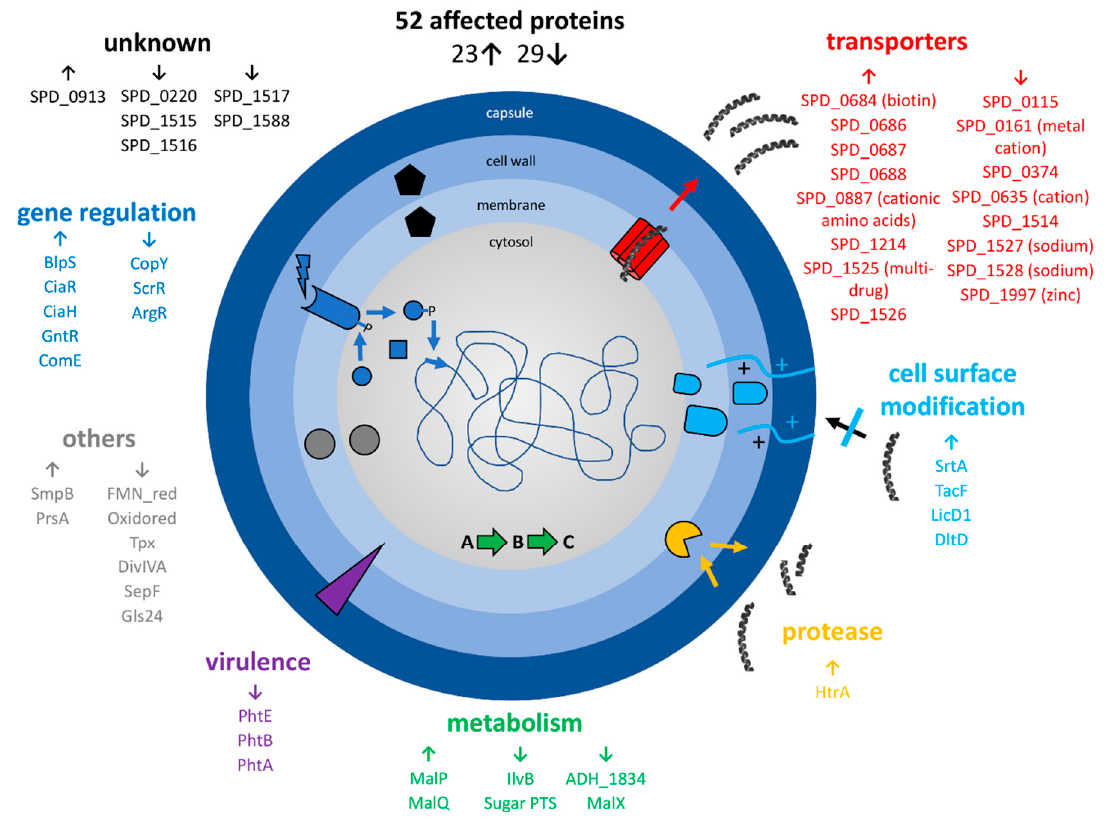
Figure 6. Summary of selected proteomic changes of S. pneumoniae D39 upon LL-37 exposure after comparison of significant# proteome changes with published transcriptome and genome data. The arrows indicate an increase or a decrease in protein abundance after application of the stress, respectively. # Student’s t -test ( p -value = 0.01, min. fold change = 1.5).